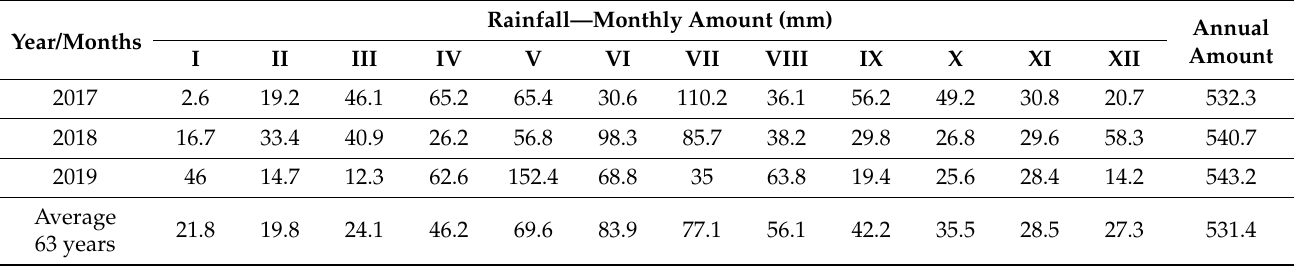
Table 2. Rainfall regime from 2017 to 2019 at the ARDS